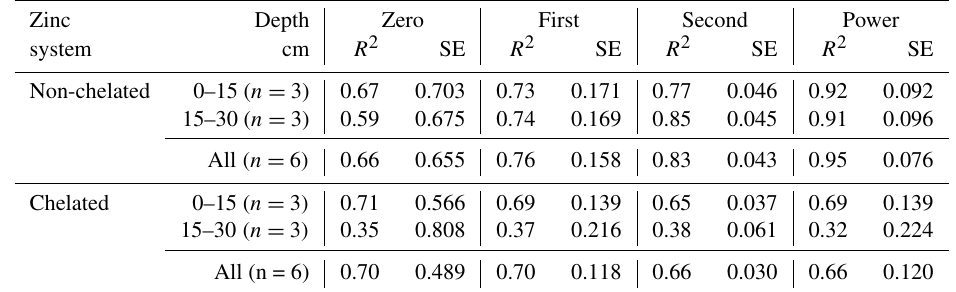
Table 5. Coefficient of determination ( R 2 ) and standard error (SE) of kinetic models used in examining Zn fixation kinetics in the semi-arid alkaline soils of the Southern High Plains,